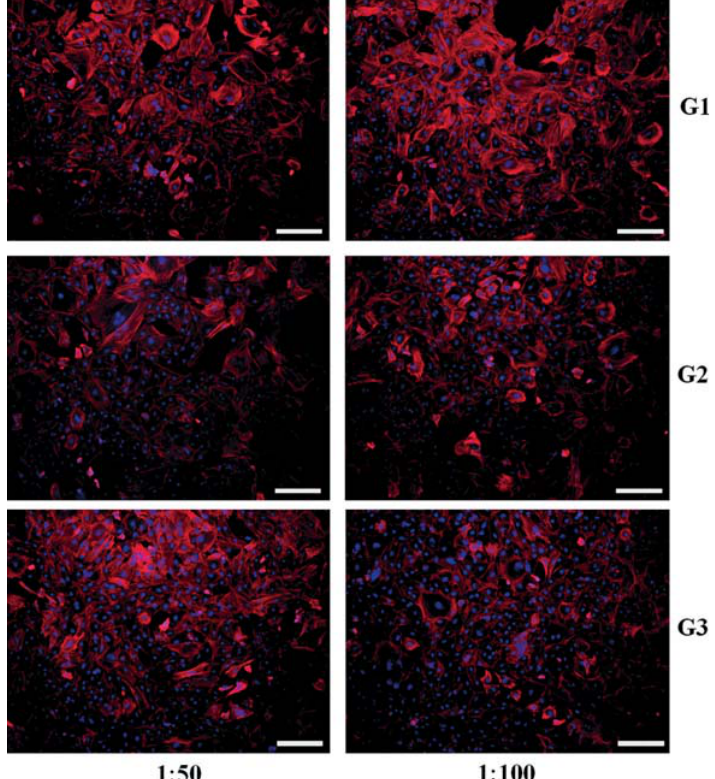
Figure 6- Morphologies of rat dental pulp stem cells cultured in dilutions of cement extract (G1-G3) by CLSM (stains of